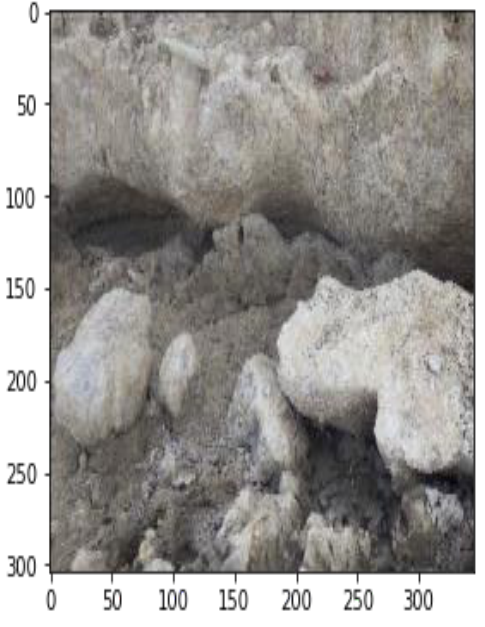
Figure 9. An error created by the baseline model, producing a different rock type. The dominant rock in the image is sandstone, whereas the baseline produced chert and CNN-B produces gray andesite.